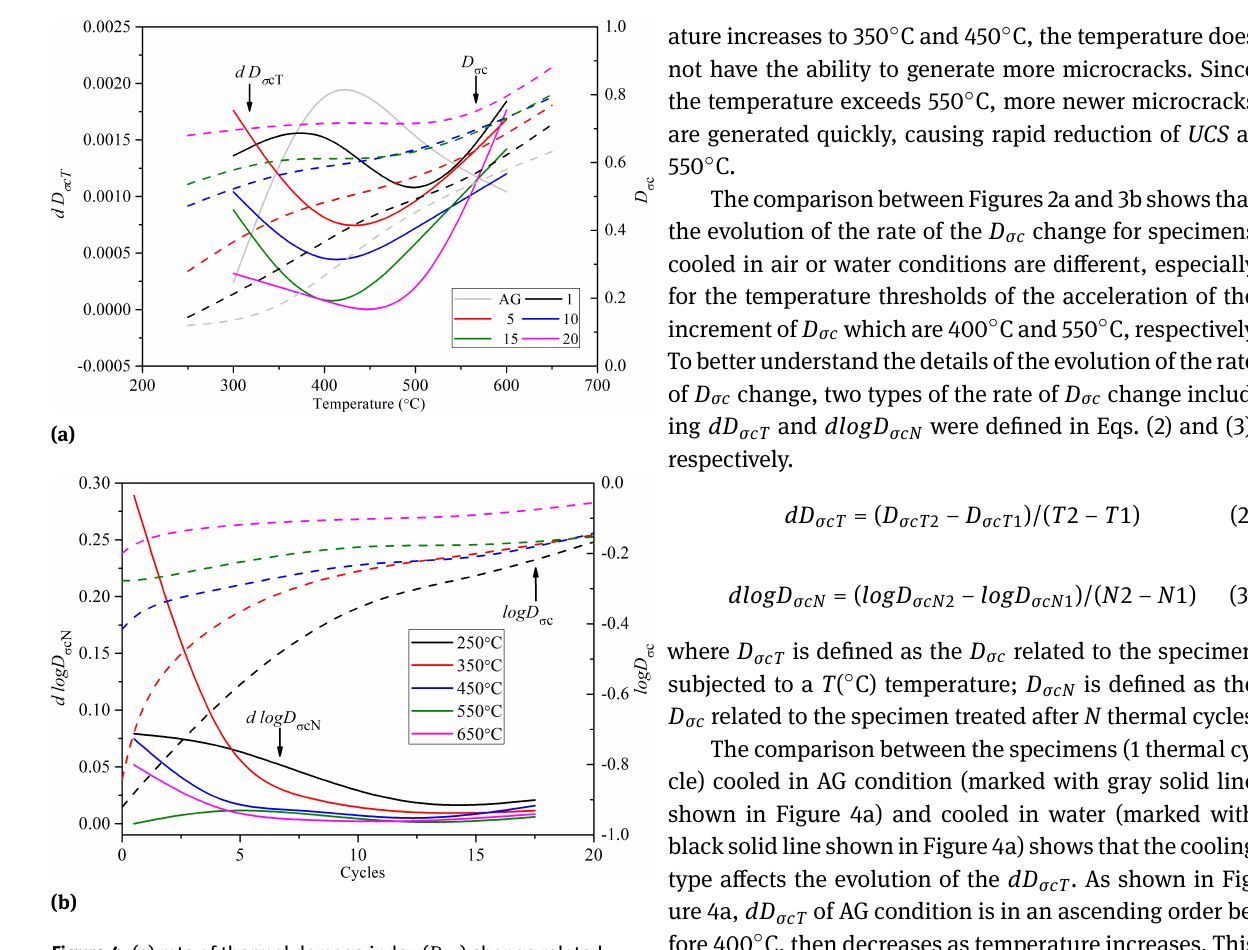
Figure 4: (a) rate of thermal damage index ( D σc ) change related to temperature, dD σcT , (solid line) and D σc (dotted line) versus temperatures, and (b) another type of rate of thermal damage index change related to thermal cycles, dlogD σcN , (solid line) and logD σc (dotted line), versus cycles